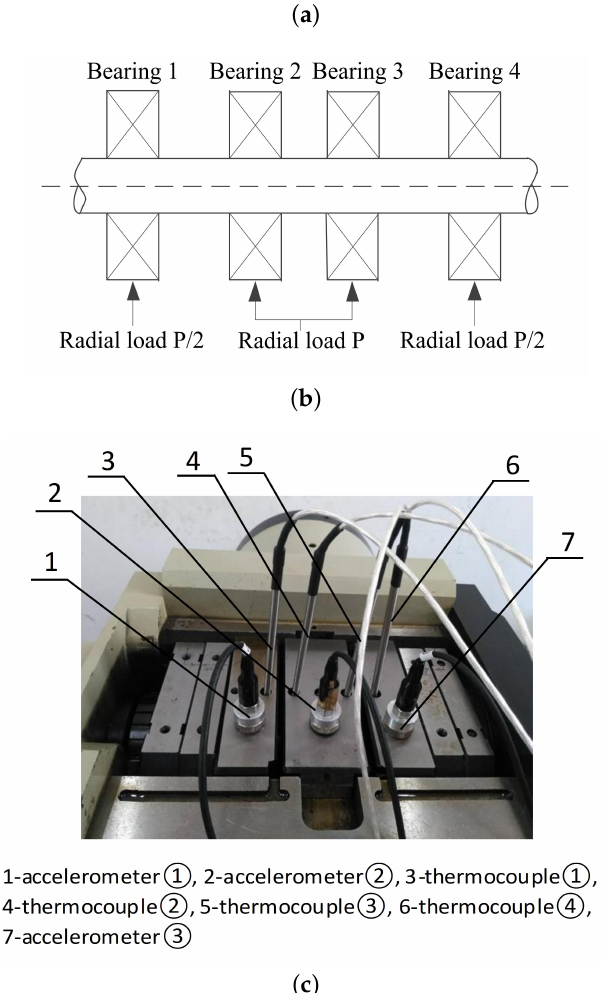
Figure 18. Rolling bearing test rig: ( a ) Bearing failure test bench. ( b ) The diagram of loading system. ( c ) Sensor